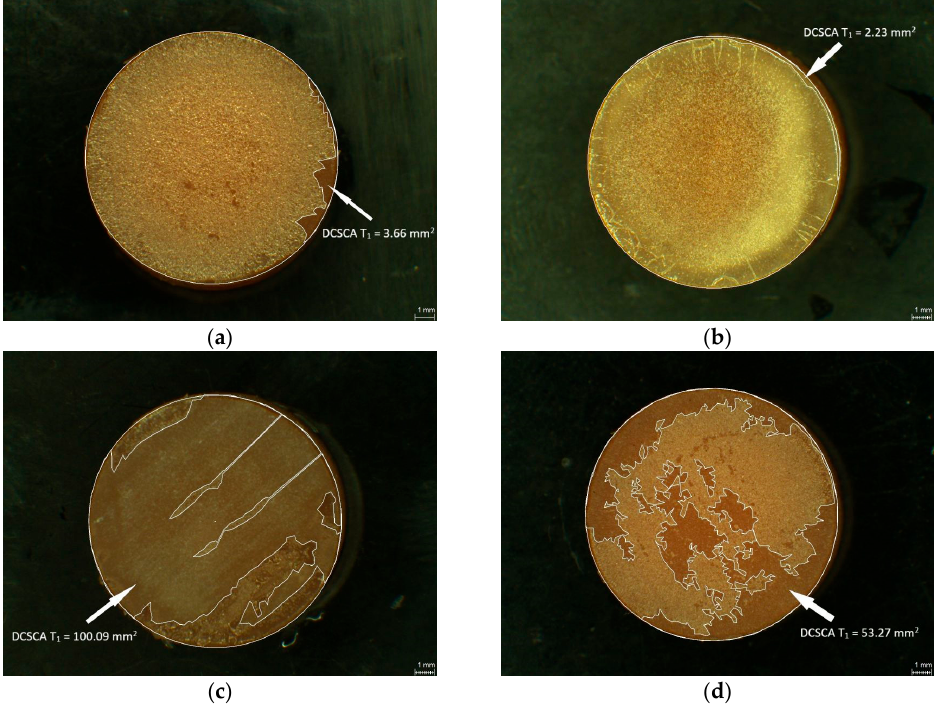
Figure 7. Selected specimens showing damaged CS coating after disinfection/abrasion tests (DCSCA at T 1 are marked with an arrow): PMMA control group ( a ); PETG L2 ( b ); PETG L3 ( c ); PMMA L4 ( d ). Figure 8a–l presents SEM images of the surface of the CS coated specimens both before (Figure